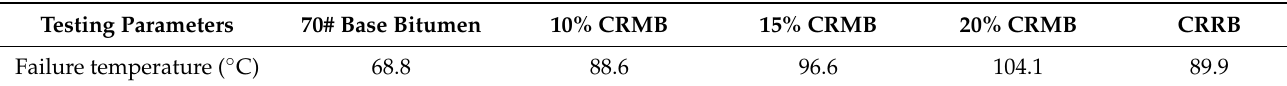
Figure 5. Rutting factor (G*/sin δ ) curve. Table 2. Failure temperature of bitumen.